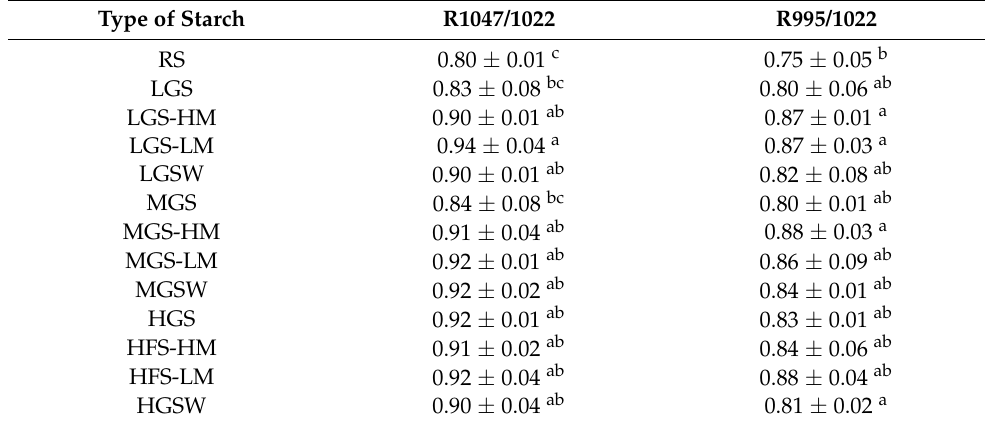
Figure 2. FTIR spectra of LGS ( a ), MGS ( b ) and HGS ( c ) reheated by different methods.